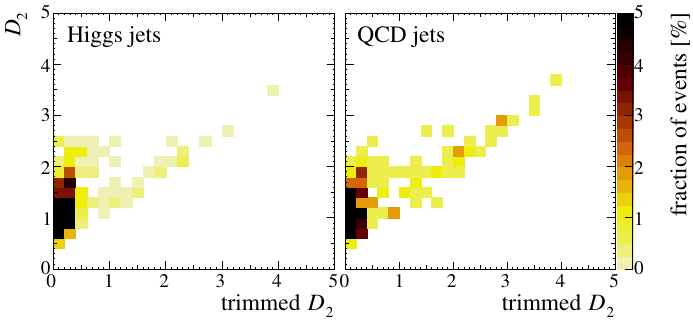
Figure 10 . Distributions of Higgs jets (left) and QCD jets (right) in D 2 and D 2 ;tr , classi(cid:12)ed as Higgs jets in N S but QCD jets in N D . We select events with Higgs-like probabilities 2 + tr 2 + tr p h ( Y D ) < 30% and p h ( Y S ) > 70%. 2 ;tr 2 ;tr